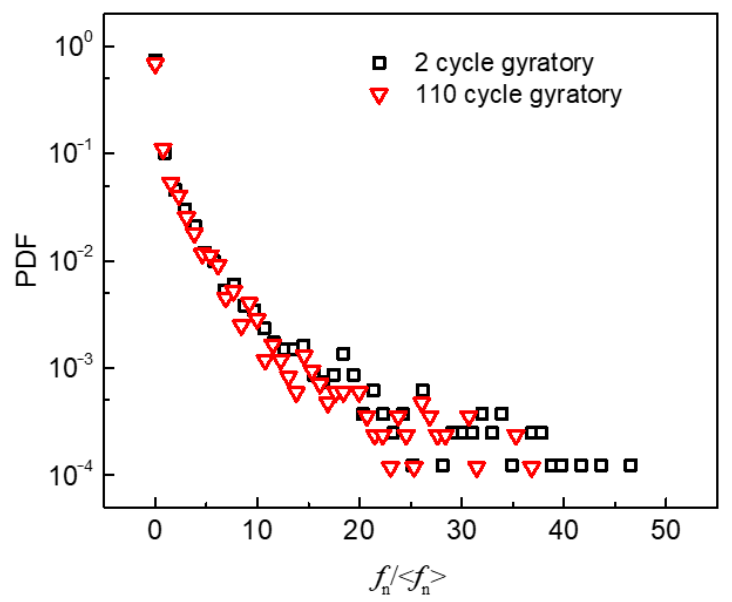
Figure 12. The evolution of the probability distribution function (PDF) for normalized normal contact force f n /< f n > with 2 and 110 compaction